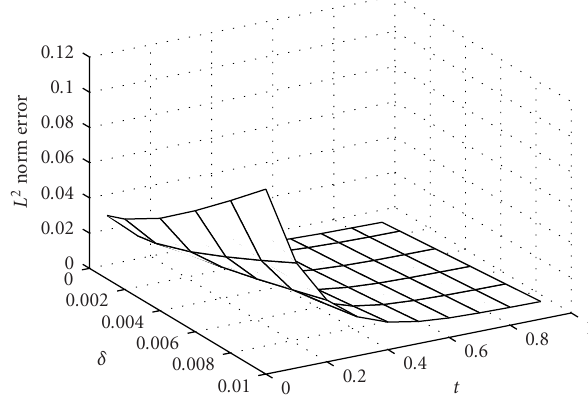
Figure 3.1. L 2 -error for various t and h with fixed δ = 0 . 001 (“optimal” h = 10 / 13